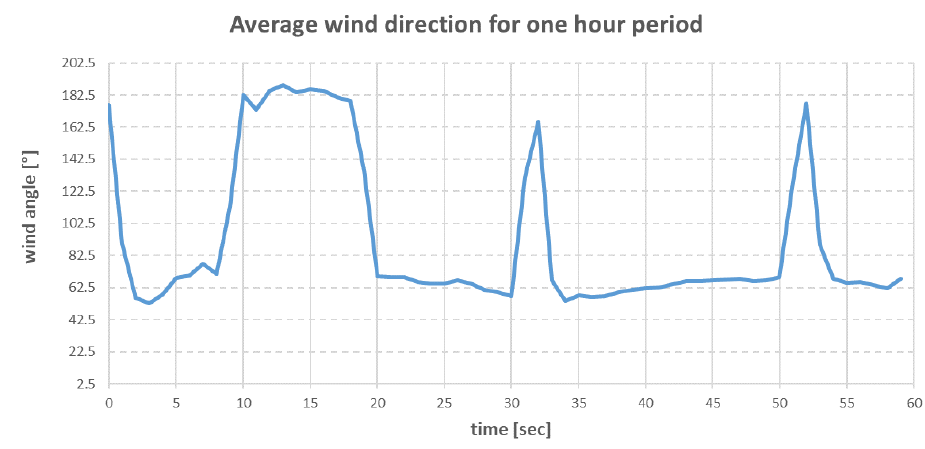
Figure 20. Wind speed changes during simulation.